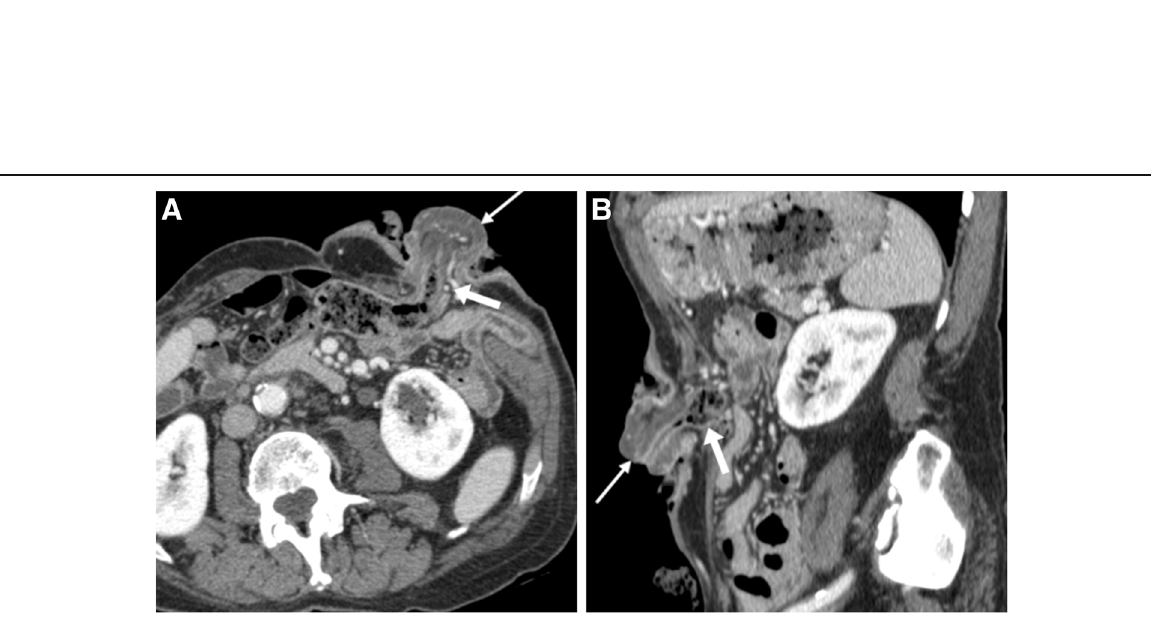
Fig. 11 Clinically confirmed protrusion of an ileostomy with markedly oedematous stomal tract (arrows) and bulging of external orifice (thin arrows), which was managed conservatively